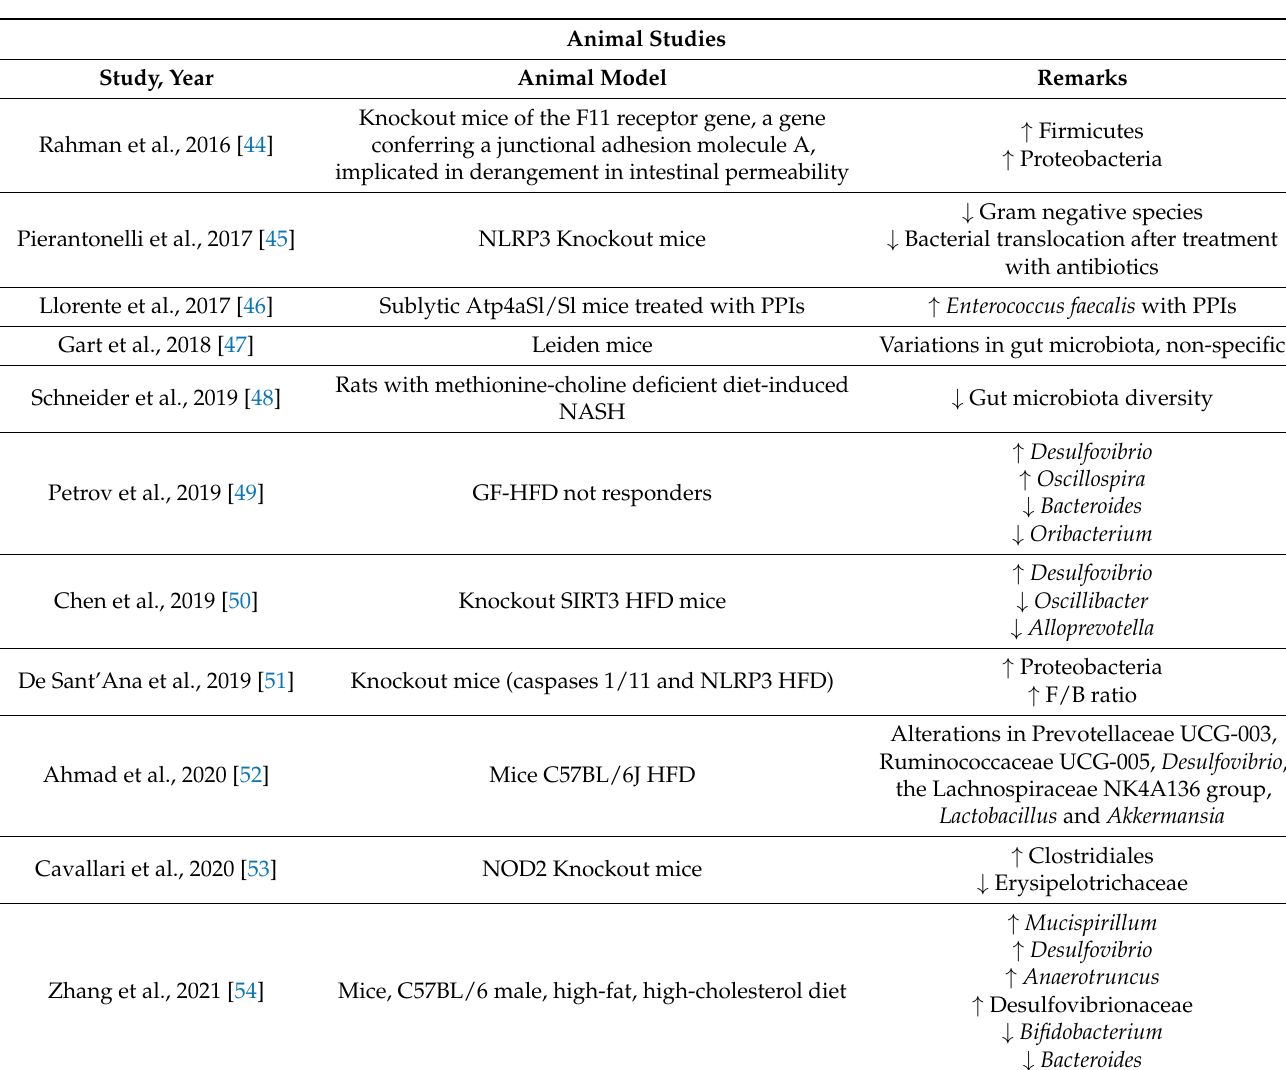
Table 1. Differences in microbial species abundance in various animal